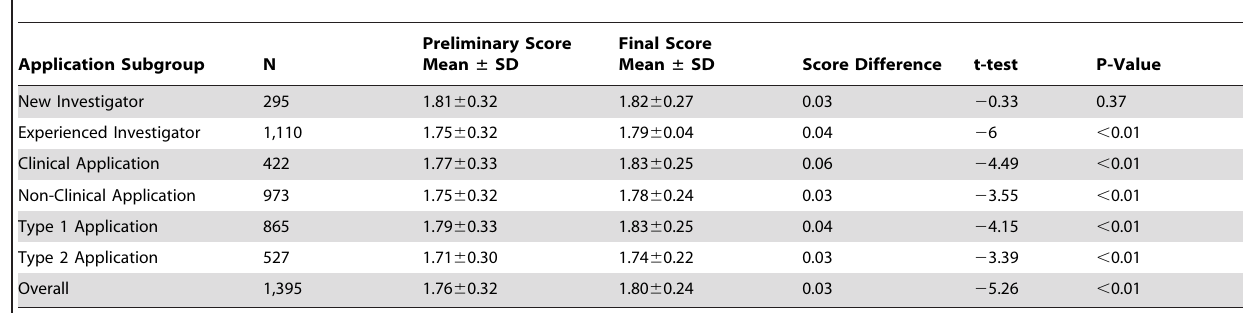
Table 1. Paired T-Test Comparing Average Preliminary and Final Priority